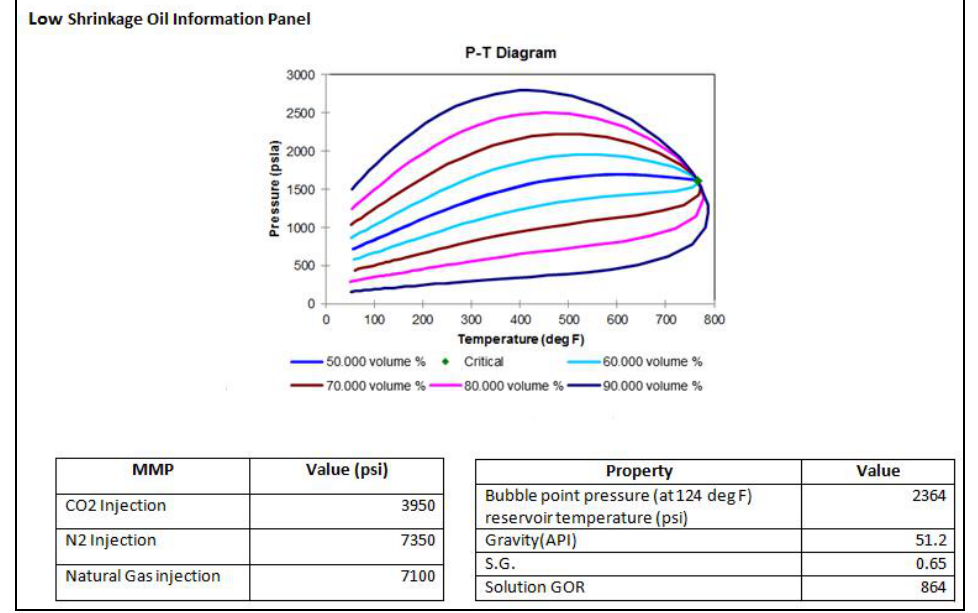
Figure 7. Main window of "information" button for low shrinkage